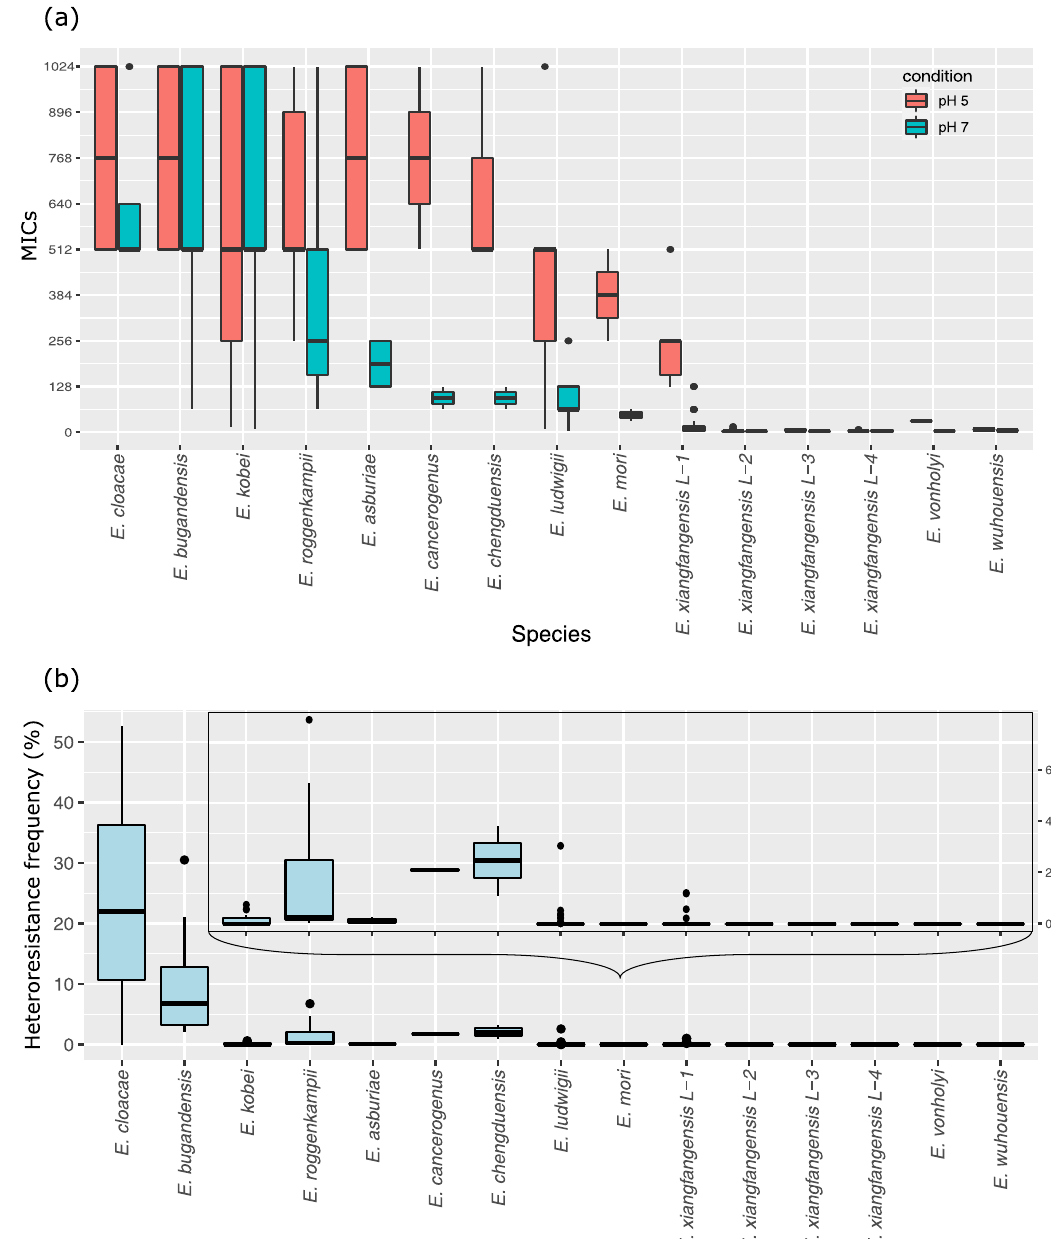
Fig. 5 | Minimum inhibitory concentration (MIC LB ) and heteroresistance frequency(HRF)ofdifferent Enterobacter species.a MIC LB and b HRF.TheMIC LB andHRFwerestudiedbyBMDassayandPAPtestforisolatesof12speciesobserved inthisstudy.Theredandblueboxes(in a )depictMIC LB atpH5and7,respectively. Enterobacter species exhibiting lower HRFs are shown also in the inset (in b ). The